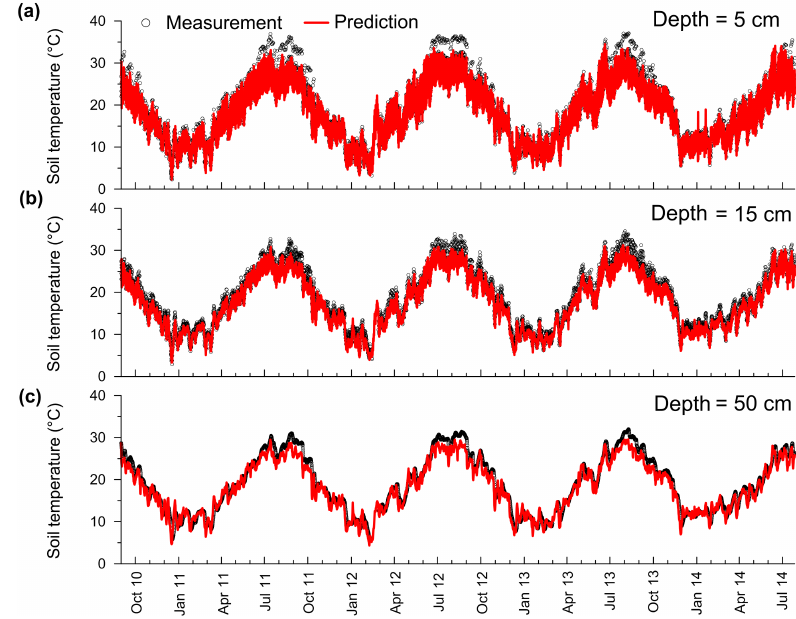
Figure 12. Measured versus IEM-predicted temperature ( T ) evolutions at three different depths